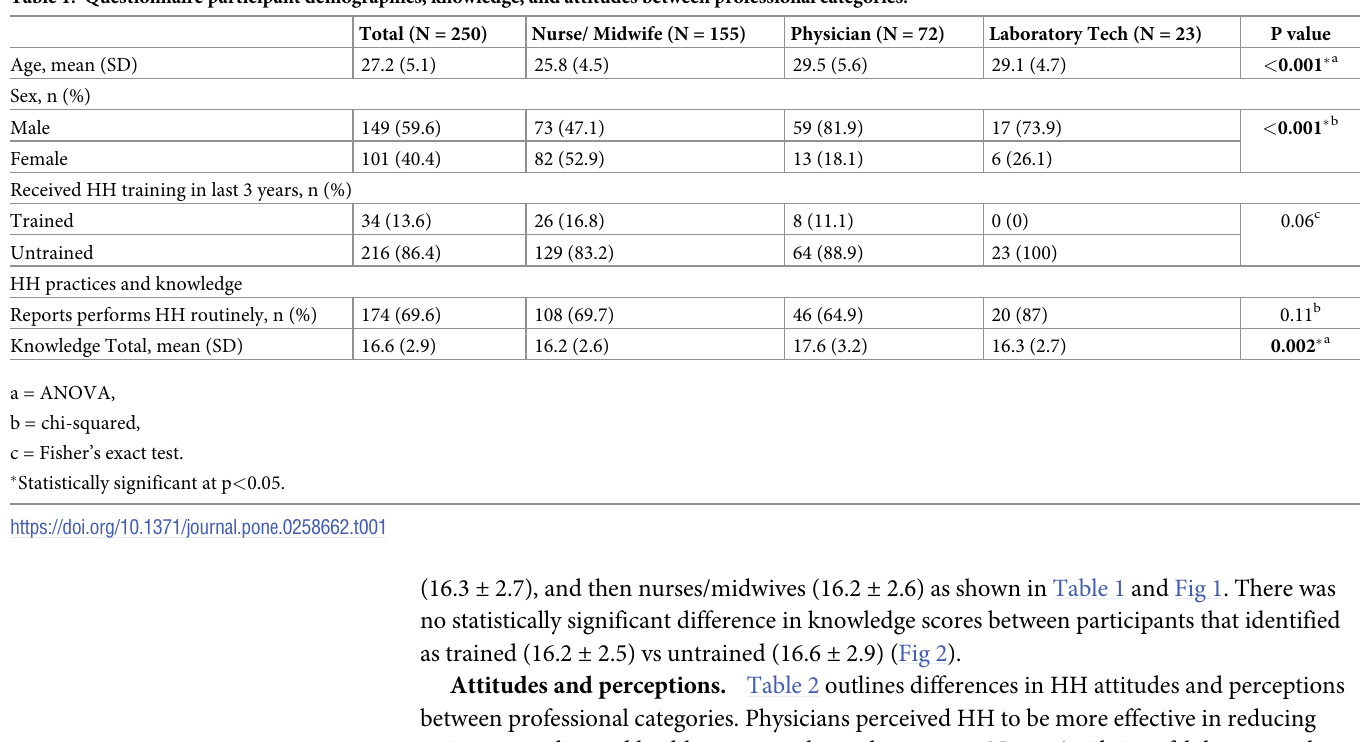
(16.3 ± 2.7), and then nurses/midwives (16.2 ± 2.6) as shown in Table 1 and Fig 1. There was no statistically significant difference in knowledge scores between participants that identified as trained (16.2 ± 2.5) vs untrained (16.6 ± 2.9) (Fig 2).